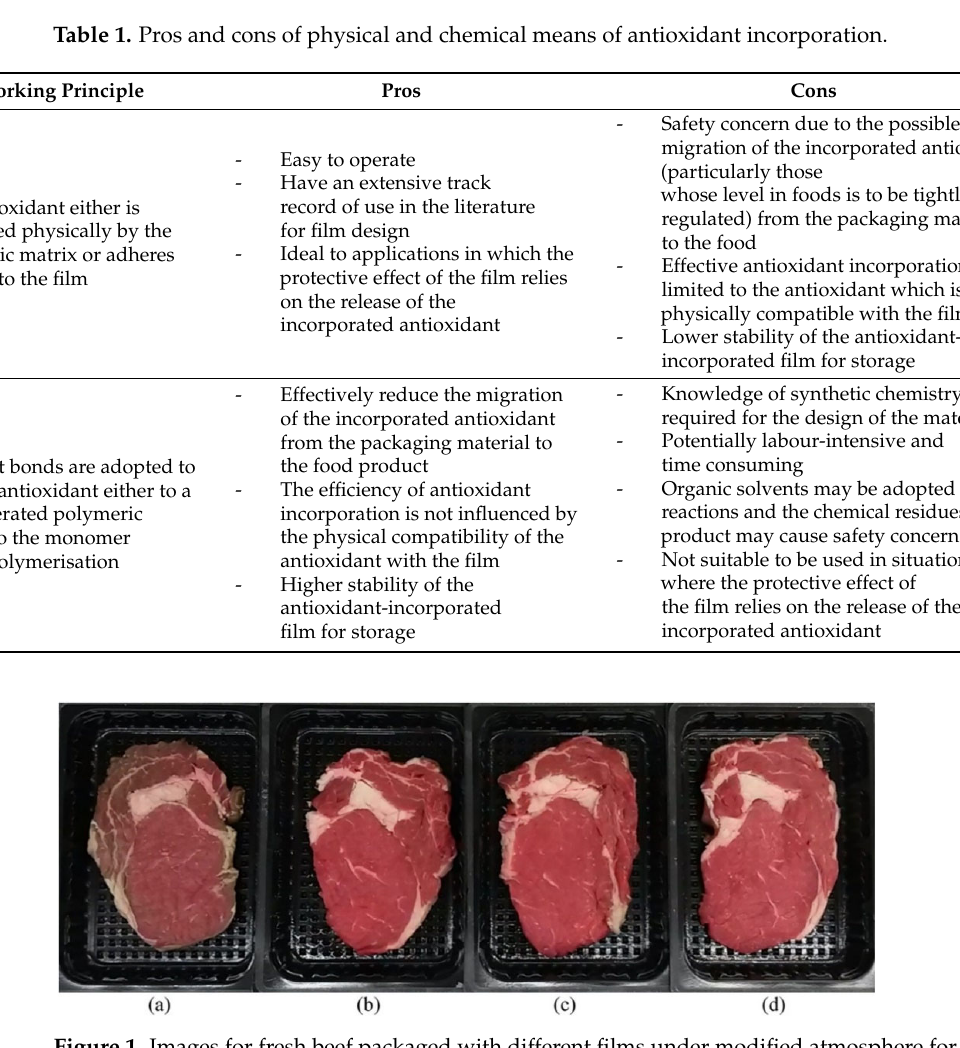
Figure 1. Images for fresh beef packaged with different films under modified atmosphere for 14 days at 2 ± 1 °C: ( a ) an uncoated OPP film, ( b ) an AC/S ‐ coated OPP film with the content of EU being 0.32 ± 0.03 g m − 2 , ( c ) an AC/S ‐ coated OPP film with the content of EU being 0.40 ± 0.14 g m − 2 , and ( d ) a CA ‐ coated OPP film with the content of EU being 0.65 ± 0.08 g m − 2 . Reproduced from [33] with permission from Elsevier B.V.